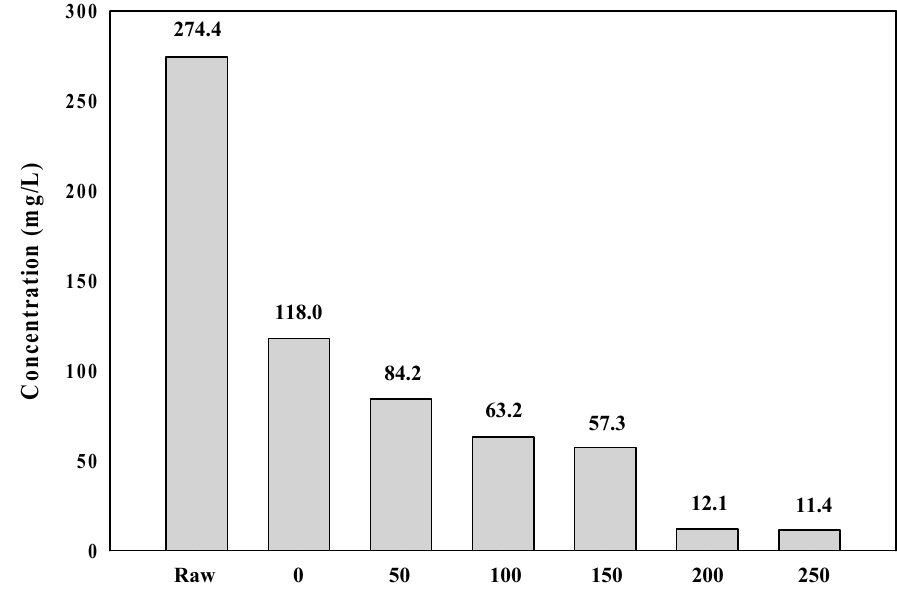
Figure 6. Polysaccharide concentration in feed and permeate water.